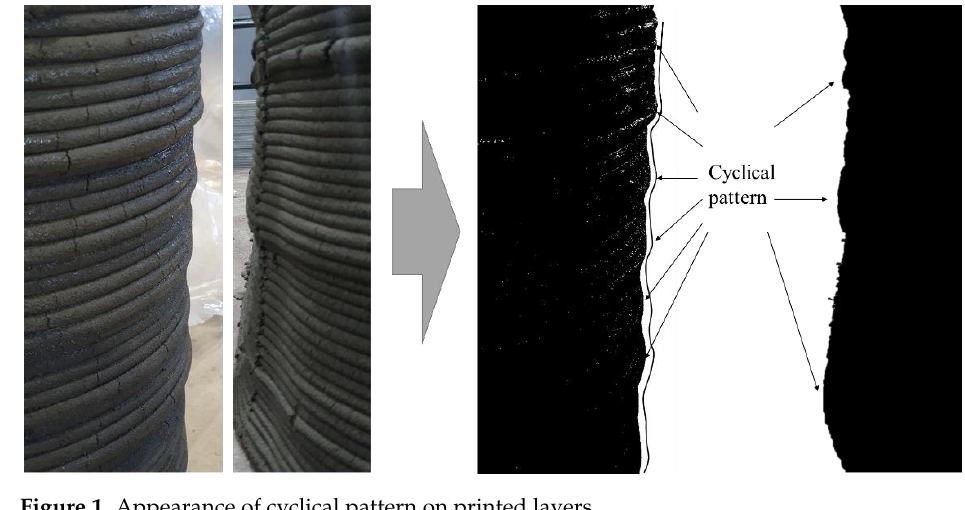
Figure 1. Appearance of cyclical pattern on printed layers.